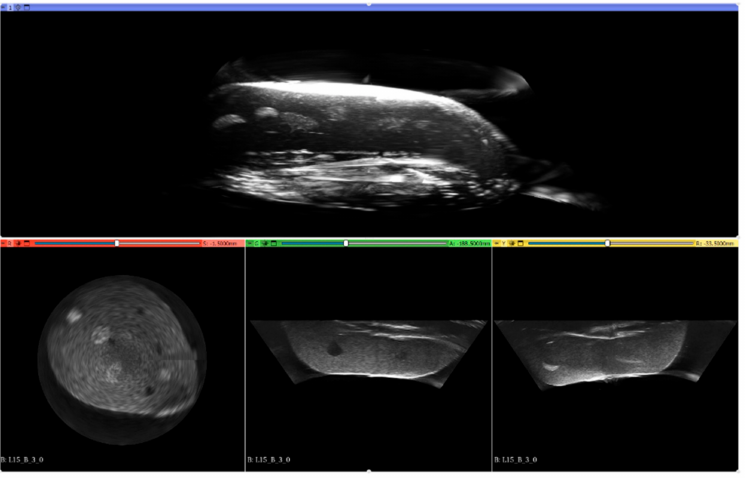
Figure 7. Example 3D reconstruction of the imaged structure of Blue Phantom Breast